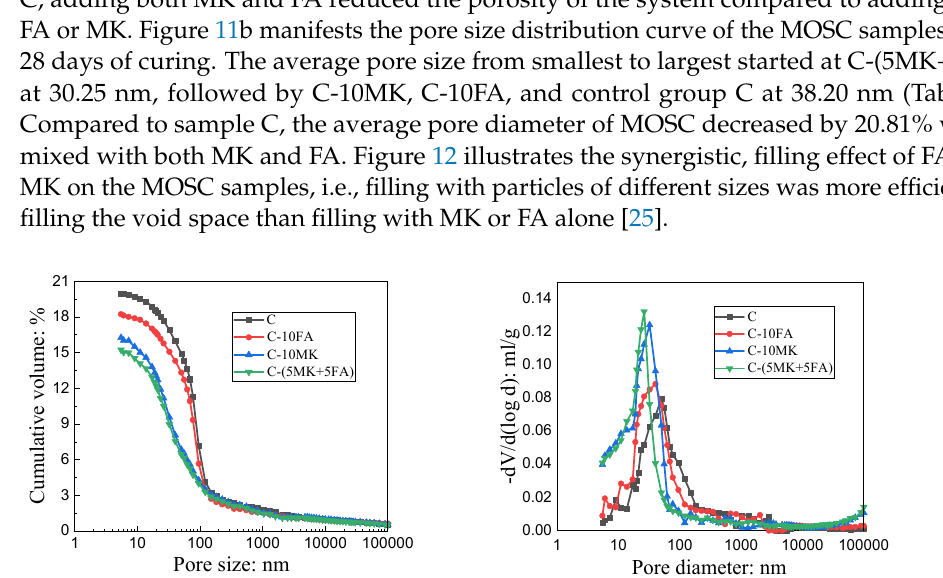
Figure 10. SEM images of MOSC with different mineral admixtures after 28 days of curing: ( a ) C; ( b ) C-10FA; ( c ) C-10MK; ( d ) C-(5MK+5FA). Remark: Phase 517 is shown in the yellow frame.